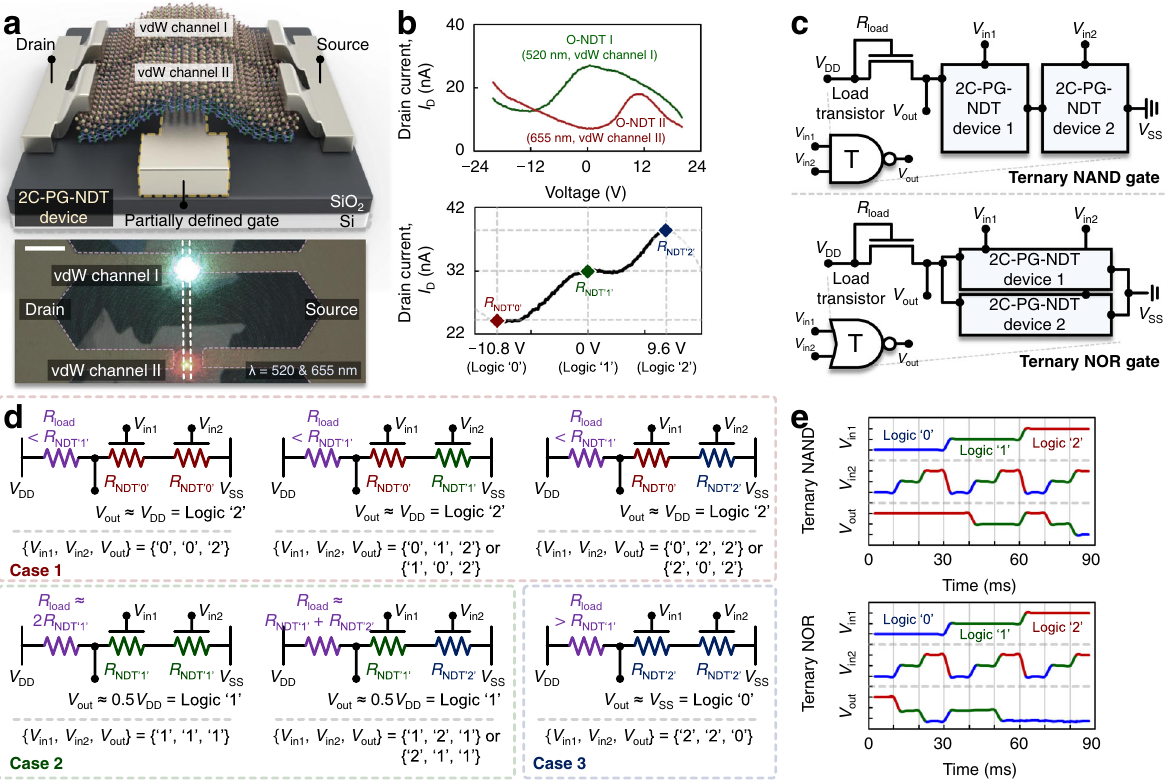
Fig. 4 Ternary NAND/NOR gate using two-channel PG-NDT devices. a Schematic and OM image of PG-NDT device with two vdW channels under laser-on conditions (wavelengths of 520 and 655 nm). b I D − V G characteristic curves showing the single O-NDT phenomena induced in the vdW channels I (520 nm) and II (655 nm). I D − V G characteristic curves showing the double O-NDT phenomenon. c Circuit con fi guration of ternary NAND/NOR gate comprising the two-channel PG-NDT devices and the load transistor. d Operating principle of the ternary NAND gate. e Timing diagrams for the ternary NAND gate and ternary NOR